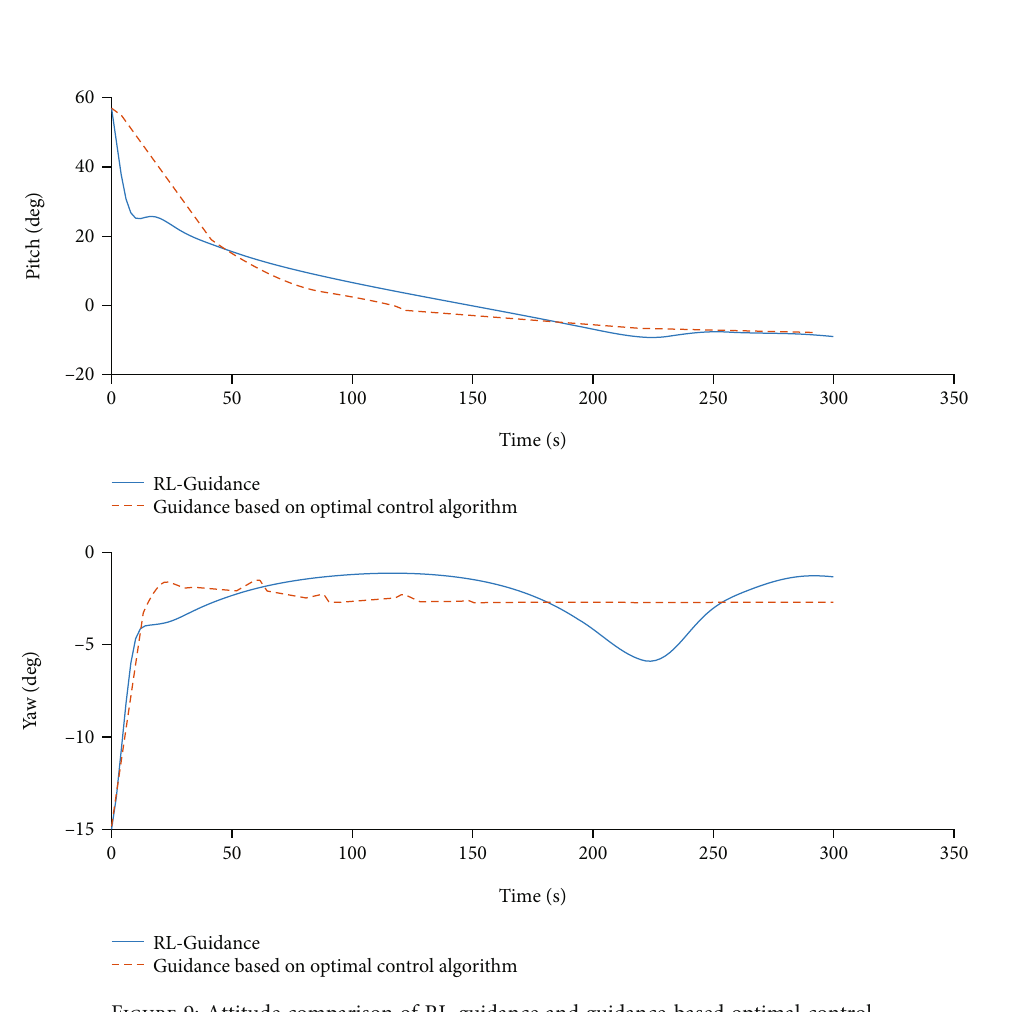
RL-Guidance Guidance based on optimal control algorithm Figure 9: Attitude comparison of RL-guidance and guidance-based optimal